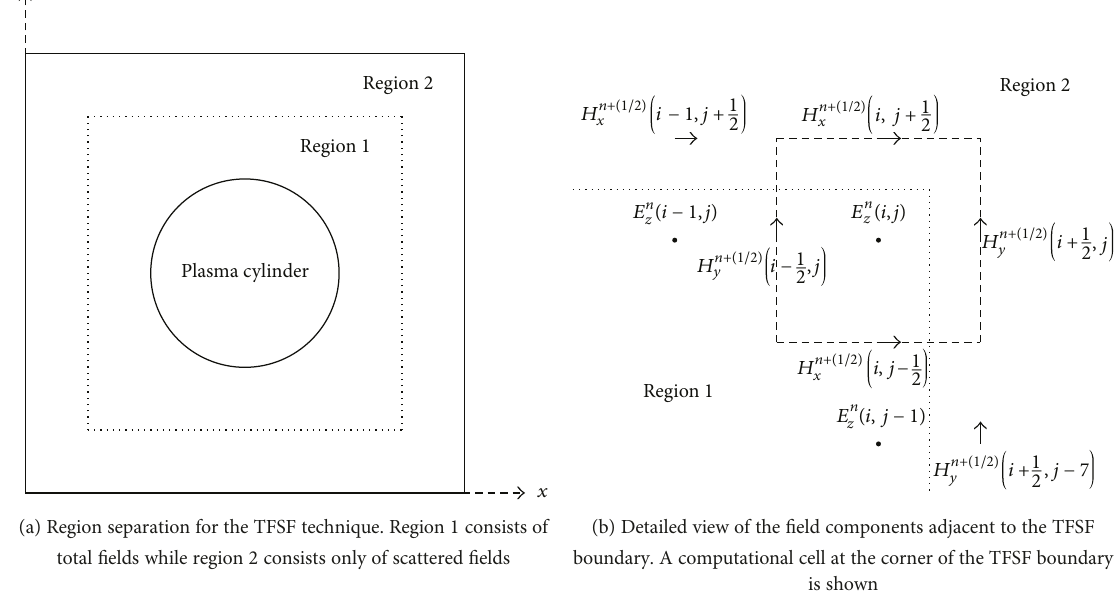
Figure 3: Total- fi eld scattered- fi eld technique used to generate the incident fi elds and calculate the scattered far fi